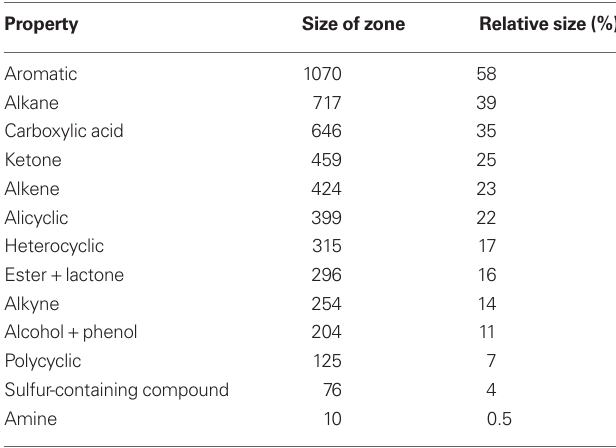
Table 1 | Sizes of coding zones.